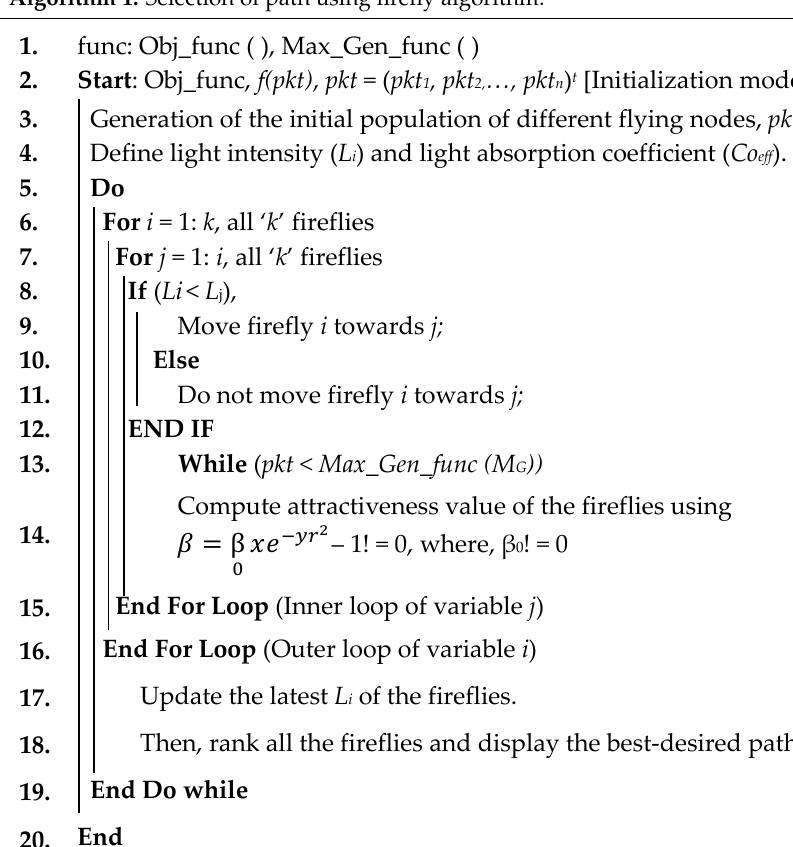
Algorithm 1. Selection of path using firefly algorithm.